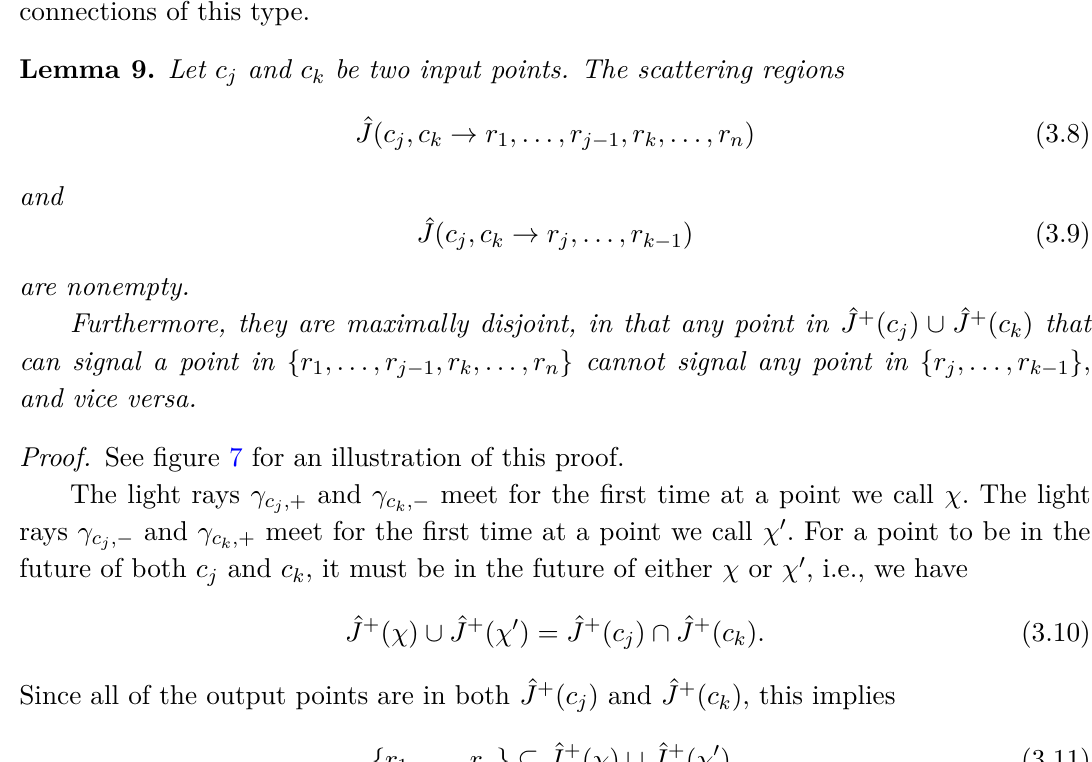
Figure 6. Illustration of the proof of lemma 8. The ray γ r and we label the point where γ each of the x must lie to the past of the light rays γ i , y i right of x . Because p must be a y j +1